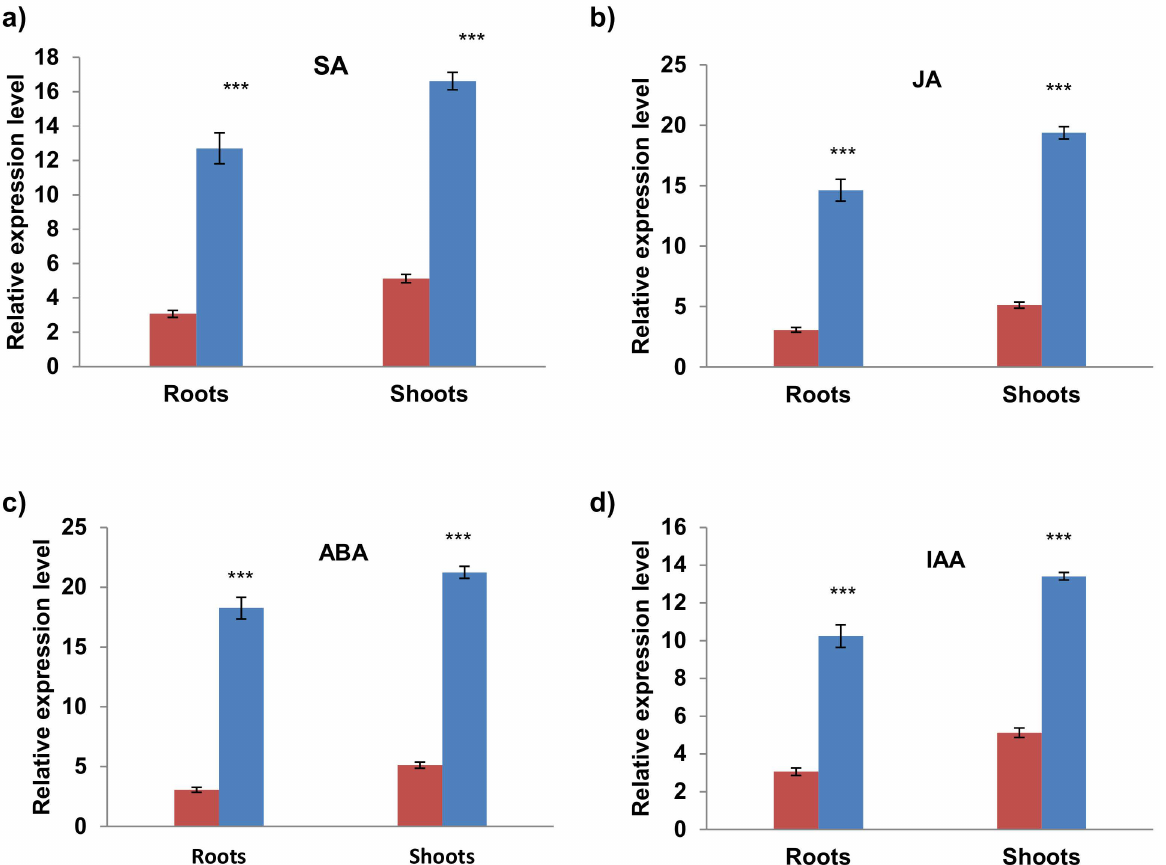
Figure 7. qRT-PCR expression analysis of AvPR-1 gene under different hormonal stresses ( a ) Salycilic acid (SA) ( b ) Jasmonic acid (JA) ( c ) abscisic acid (ABA), and ( d ) IAA. The red bars represent the expression level of the AvPR-1 gene under standard conditions, and the blue bars represent the expression level of the AvPR-1 gene under stressed conditions. (***) indicates value significantly different from the control. Statistical significance was assessed by applying the student t -test at p <